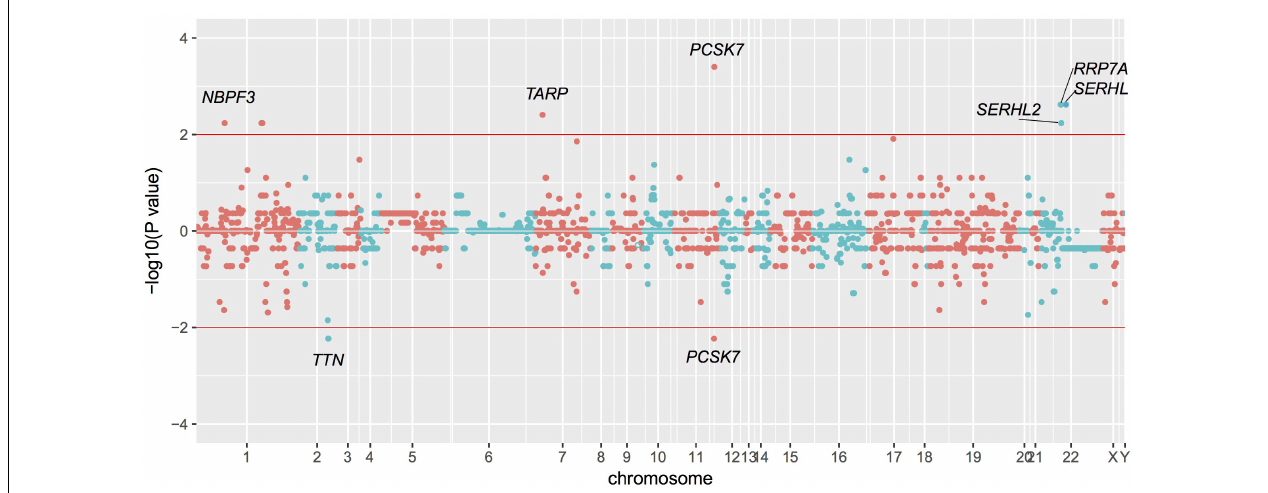
FIGURE 2 | Manhattan plot of CNVs detected by whole exome sequencing. CNVs detection by statistical comparisons between the case and control groups. Different colors of points mean CNVs from different chromosome. P > 0 means duplication while P < 0 means deletion.